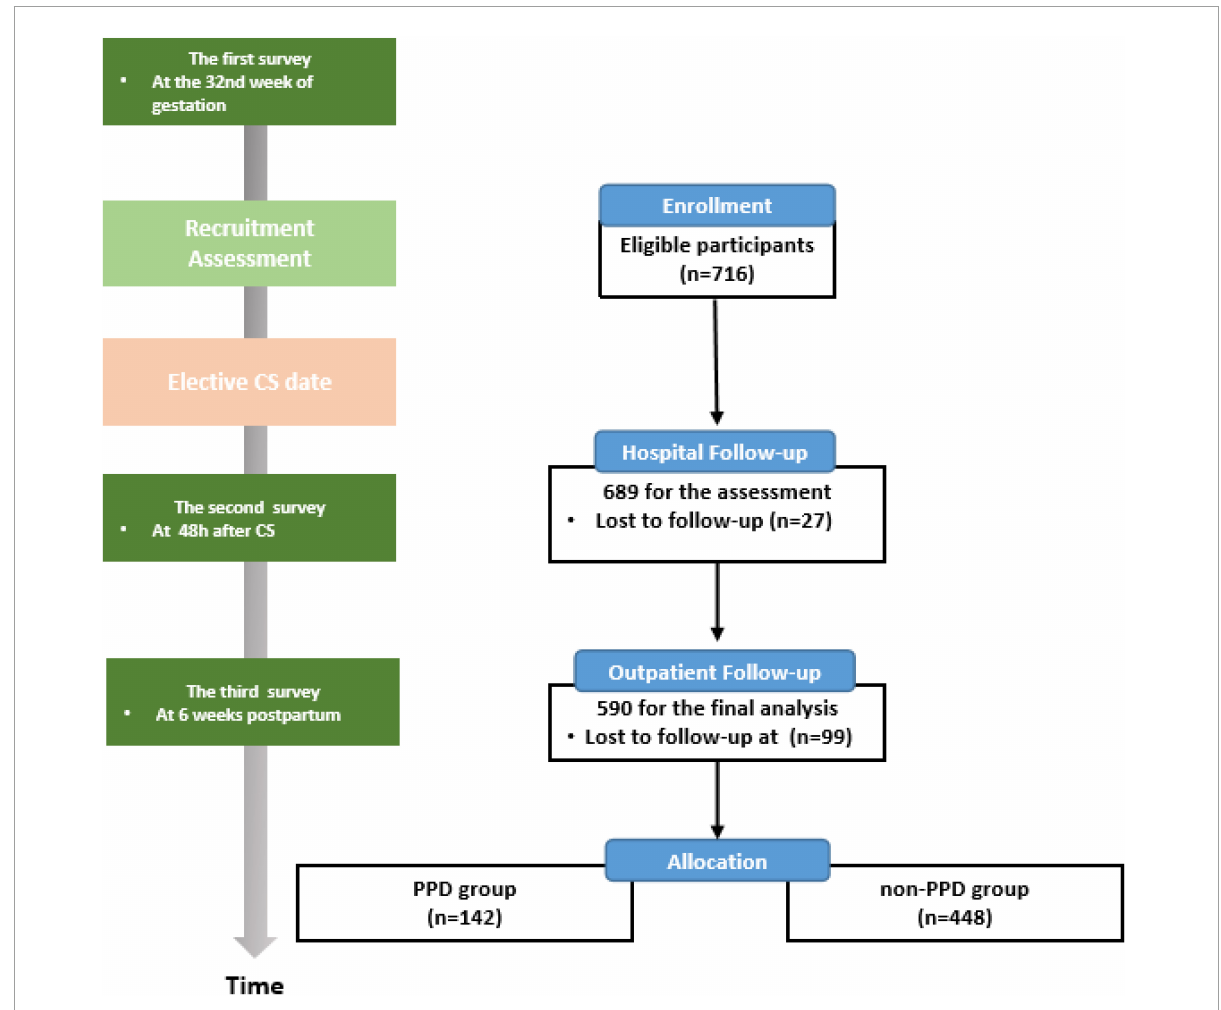
FIGURE1 Flow diagram of participant recruitment and the timeline for the three surveys. PPD, postpartum depression; CS, cesarean